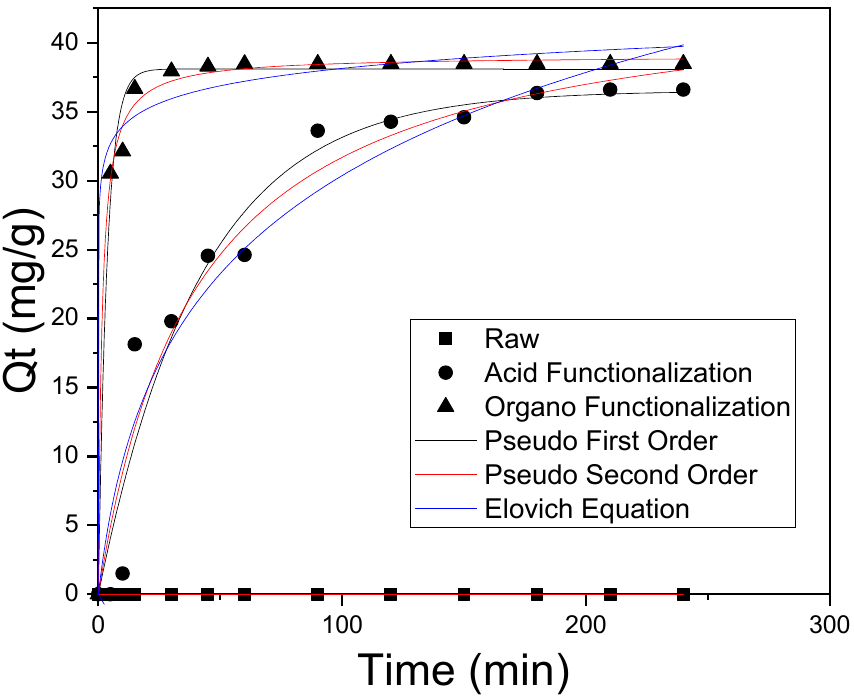
Figure 8. Representation of the fit for raw and functionalized samples to the kinetic model of pseudo-first-order, pseudo-second-order and Elovich Equation (m = 0.05 g, C = 50 mg·L −1 , pH = 6, time = 4 h at 25 °C with 200 rpm rotation). Table 8. Kinetic parameters and ANOVA obtained experimental data of SD adsorption in acid- functionalized sample fitting to the models of pseudo-first-order, pseudo-second-order and Elovich.